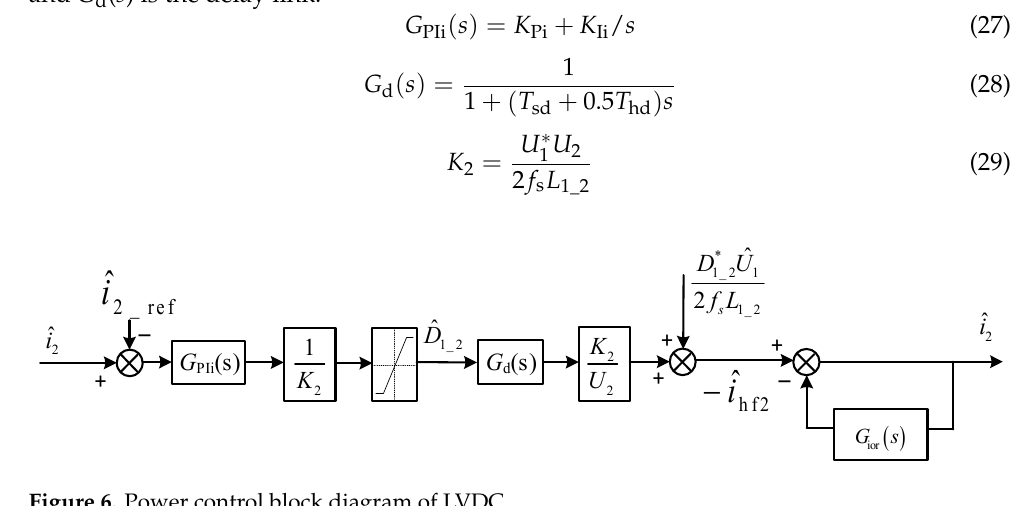
Figure 6. Power control block diagram of LVDC.